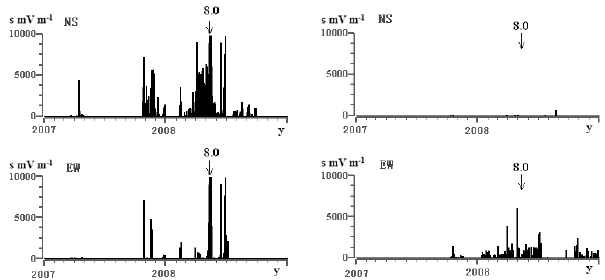
Fig. 2. Timeline of daily total cumulative amplitude A (black bar) of electromagnetic information recorded at (a) Gaobeidian station and (b) Ningjin station from January 2007 to December 2008. Wenchuan EQ is indicated by an